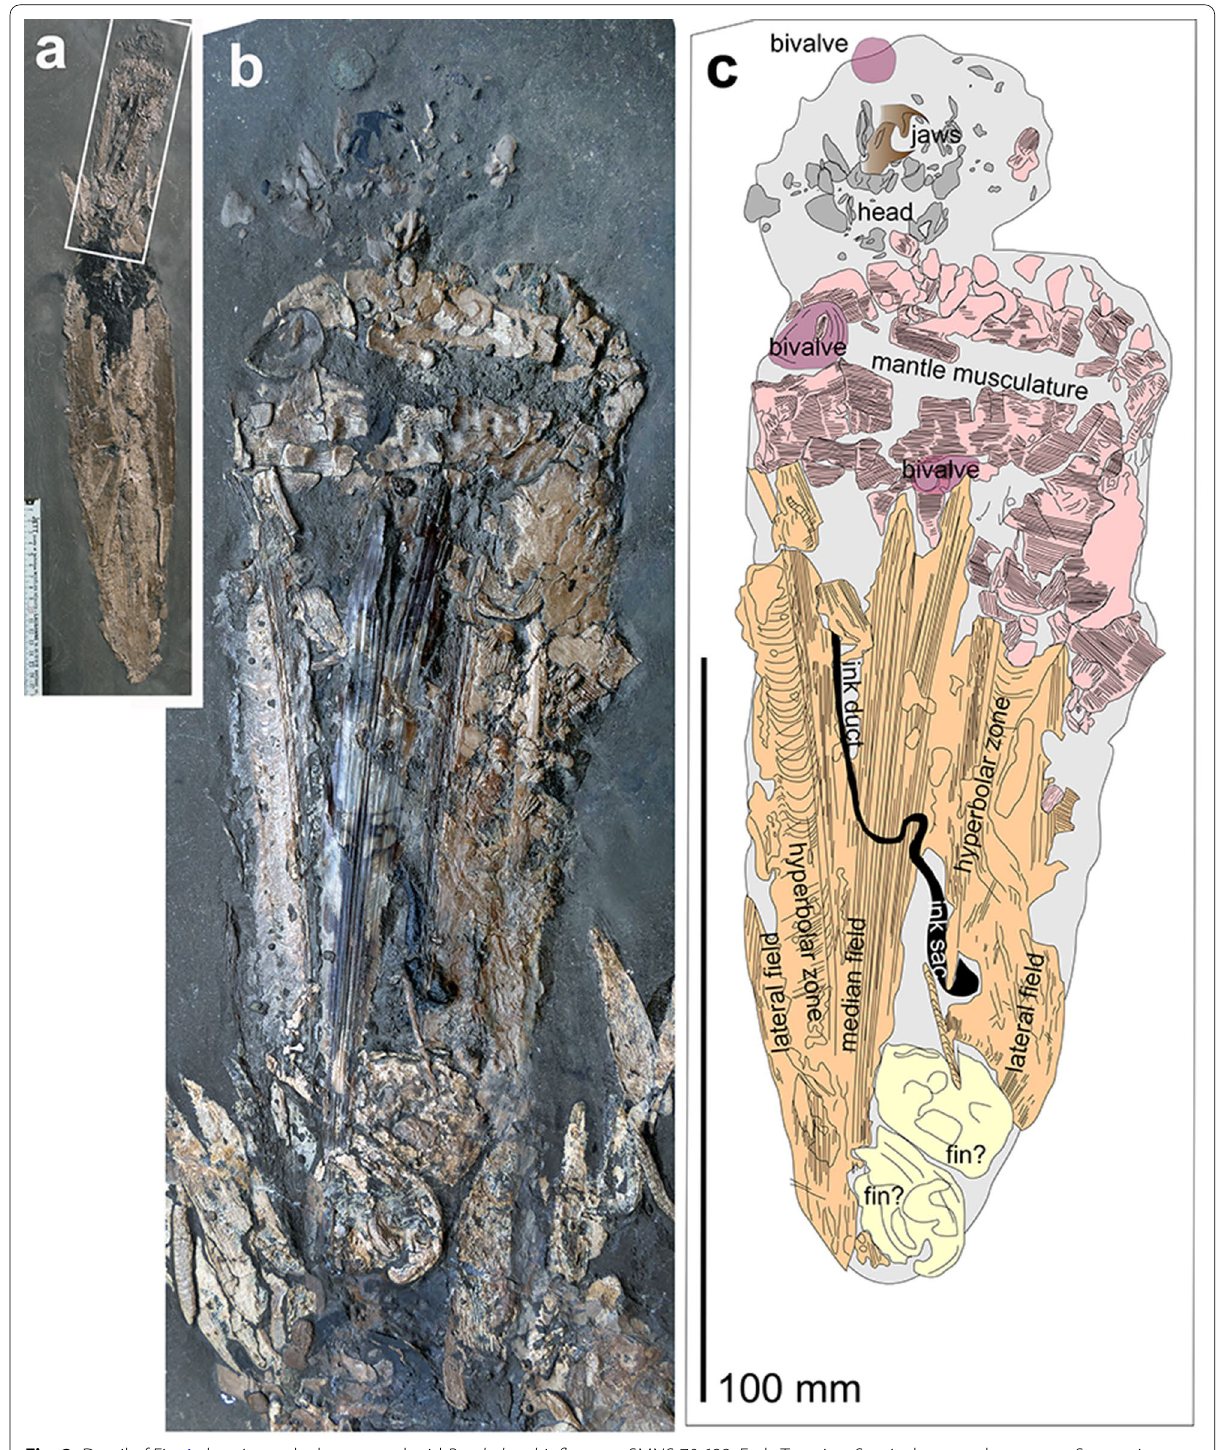
Fig. 2 Detail of Fig. 1 showing only the prey-coleoid Parabelopeltis flexuosa ; SMNS 70,623, Early Toarcian, Semicelatum to lowermost Serpentinum Zone, Ohmden, Germany. a Overview of the fossil with a rectangle showing the localisation of b . b Detail of Fig. 1b showing the prey coleoid and the arm crown of the predator. c Drawing after b to show the anatomical details of the